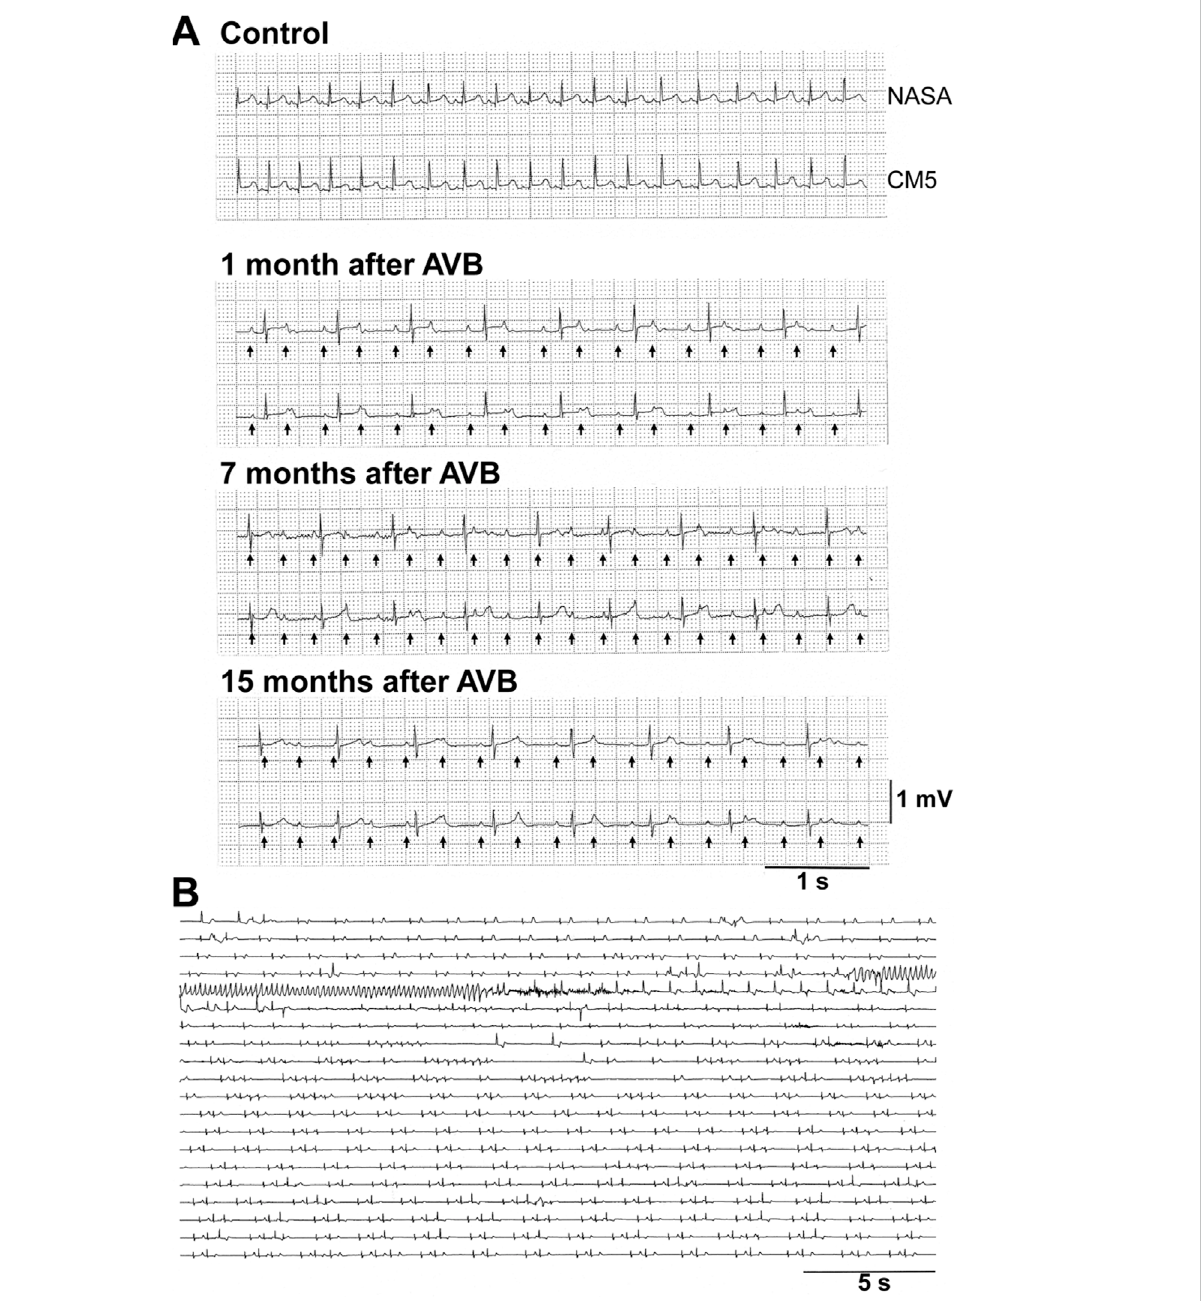
FIGURE 1 Representative traces of electrocardiogram in cynomolgus monkeys. (A) Representative traces by NASA (upper) and CM5 (lower) leads under non- ablated condition (Control) and 1, 7, and 15 months after atrioventricular node ablation (AVB) in the animal #10. Arrows indicate P-waves under complete atrioventricular block. (B) dl -Sotalol-induced torsade de pointes obtained by CM5 lead in the animal #2 at 6 months after the atrioventricular node ablation. The fi rst arrhythmia episode was observed 2 h after the oral administration of 10 mg/kg of dl -sotalol hydrochloride. AVB, atrioventricular